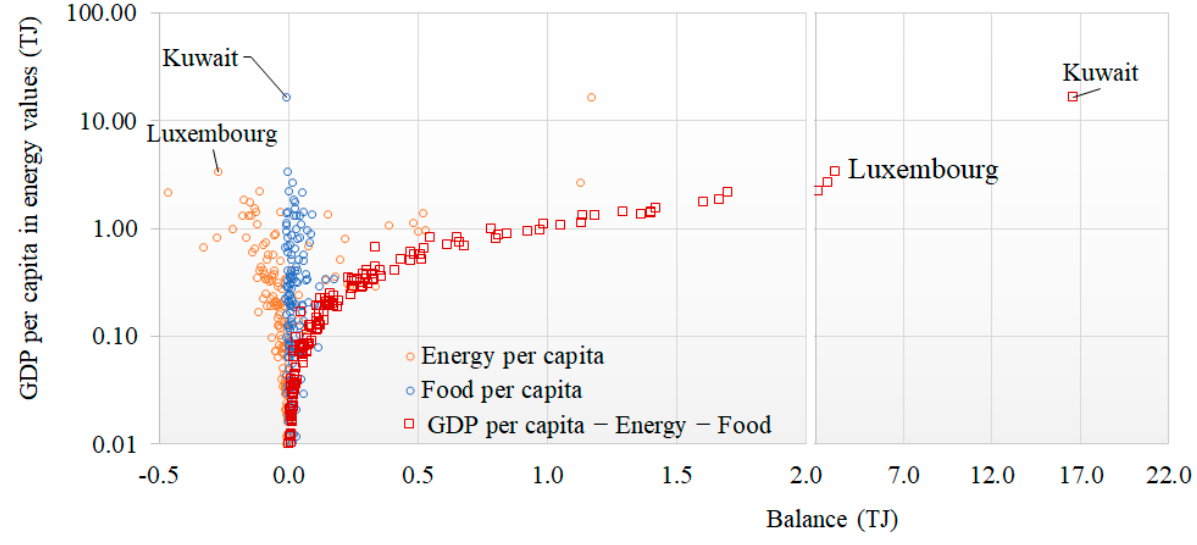
Figure 12. Balance of energy and food per capita, and GDP per capita in energy units minus the deficit (in absolute values) of energy and food per capita, vs. GDP per capita in energy units (2019).